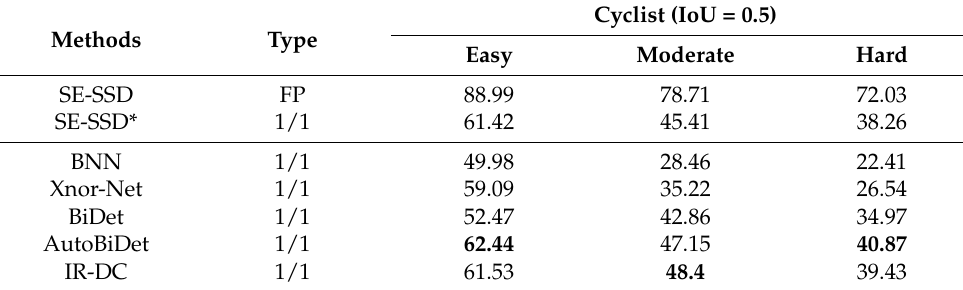
Table 5. Results of cyclist class in KITTI.